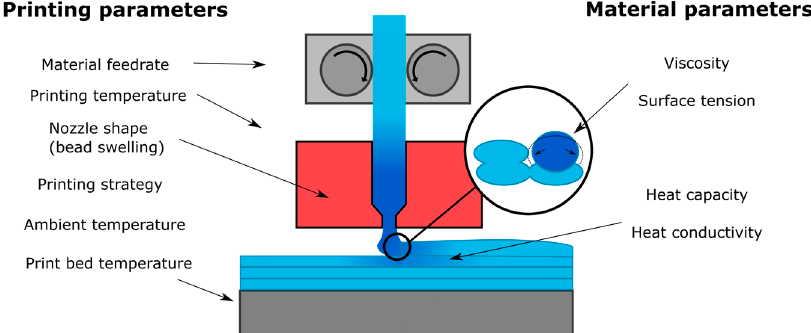
Figure 3. Main parameters for good surface contact and temperature conditions to enable optimal polymer sintering conditions.